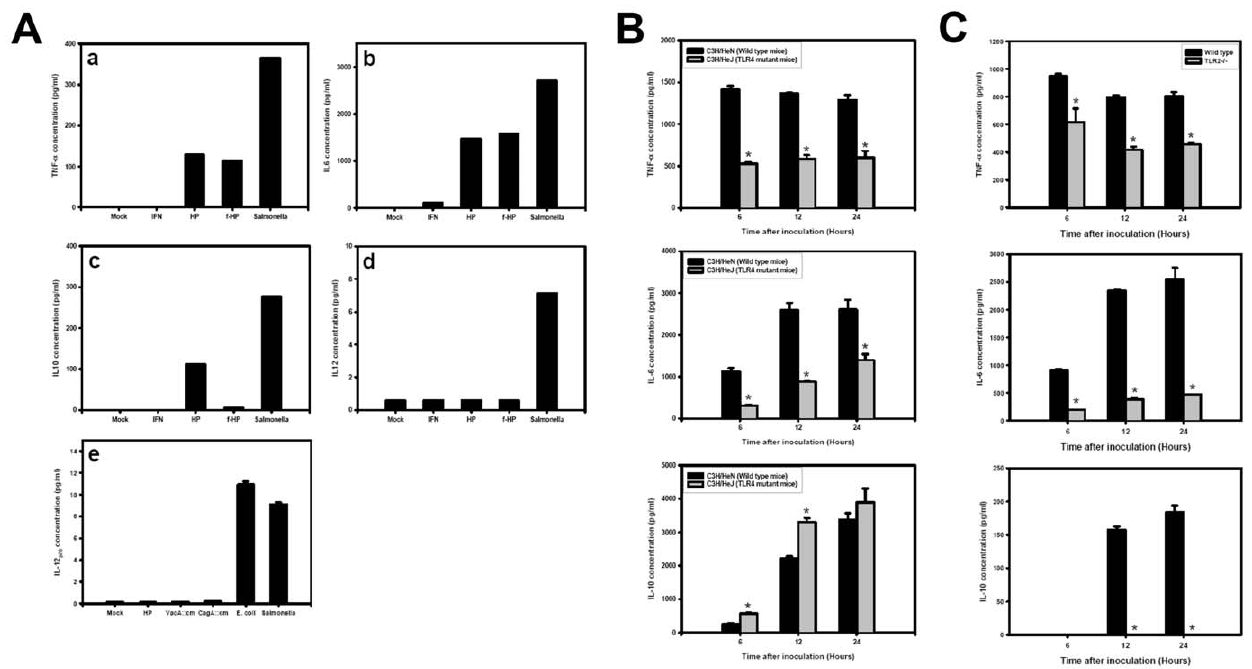
Figure 5. TNF- a , IL-6, IL10 and IL-12 p70 production of H.pylori -infected BMDCs. Cytokine production in H. pylori -infected BMDCs derived from B6 mice (A), TLR4 deficient mice (B), or TLR2 knock out mice (C). BMDCs were infected with H. pylori at m.o.i.=10. At 24 h post infection, the supernatants were collected from medium alone (mock), H. pylori , formalin fixed- H. pylori or Salmonella treated BMDCs and the TNF- a (a), IL-6 (b), IL- 10 (c), and IL-12 p70 (d,e) concentrations were determined. In (e), the vacA (VacA::cm), cagA (CagA::cm) mutants were included for comparison. (B &C) TNF- a , IL-6, and IL-10 production in H. pylori -infected BMDCs derived from wild type, TLR4 deficient, or TLR2 knock out mice, the cytokines concentration were determined at various hour post infection. * p , 0.05 via student t-test.